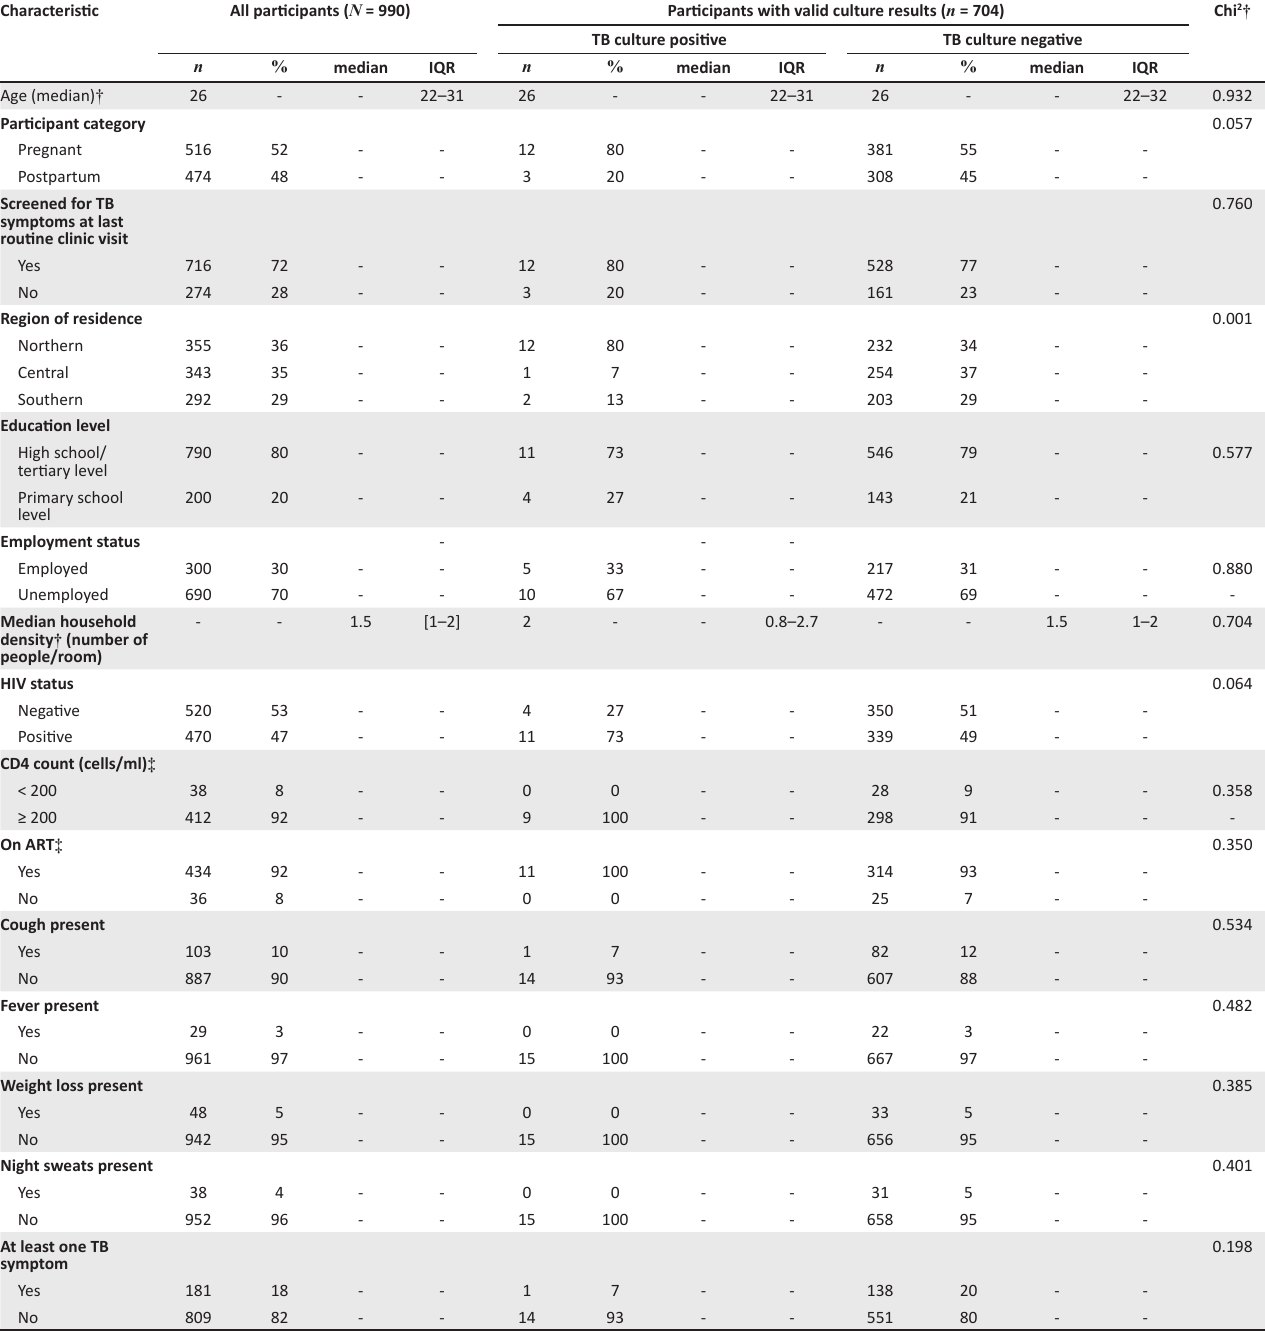
TABLE 1: Demographic characteristics of pregnant and postpartum women attending antenatal and postnatal care clinics in Eswatini between April and November 2015.